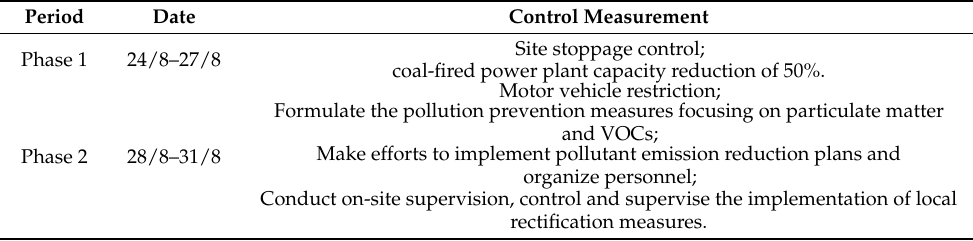
Figure 1. Time periods corresponding to the different control phases in Hangzhou, Shanghai and Yixing. Table 1. Different control periods in